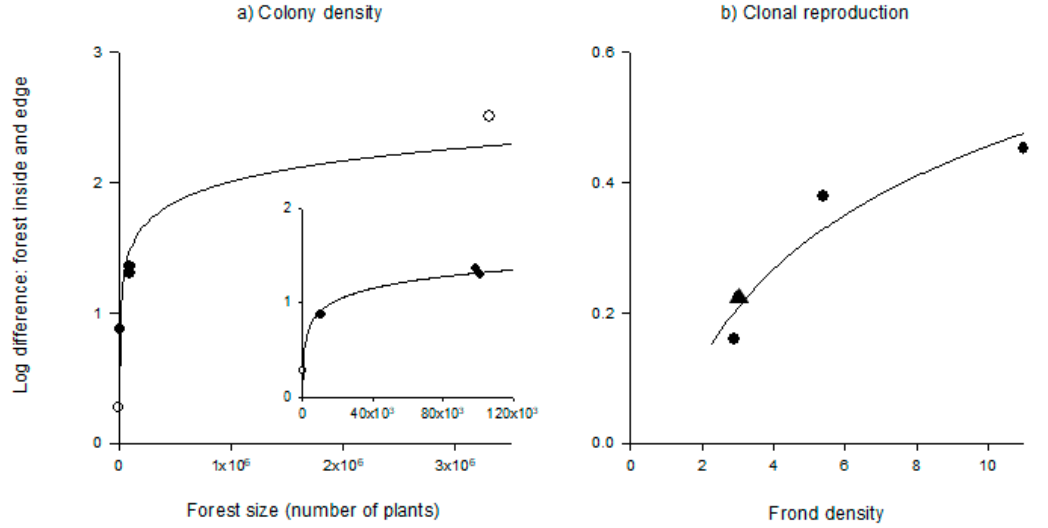
Figure 4. Relative difference between the forest edge and interior in ( a ) colony density (i.e., a time integrated measure of larval recruitment) with respect to forest size, and ( b ) clonal reproduction in relation to frond density. Closed circles are experimental data from the three forests in Santa Barbara in 2007 (this study), open circles are data from the forests in San Diego (Bernstein and Jung 1979, Dayton 1984), and the triangle is the observational data from CARP in 2006 (this study). The inset in ( a ) includes the same data without the largest forest.